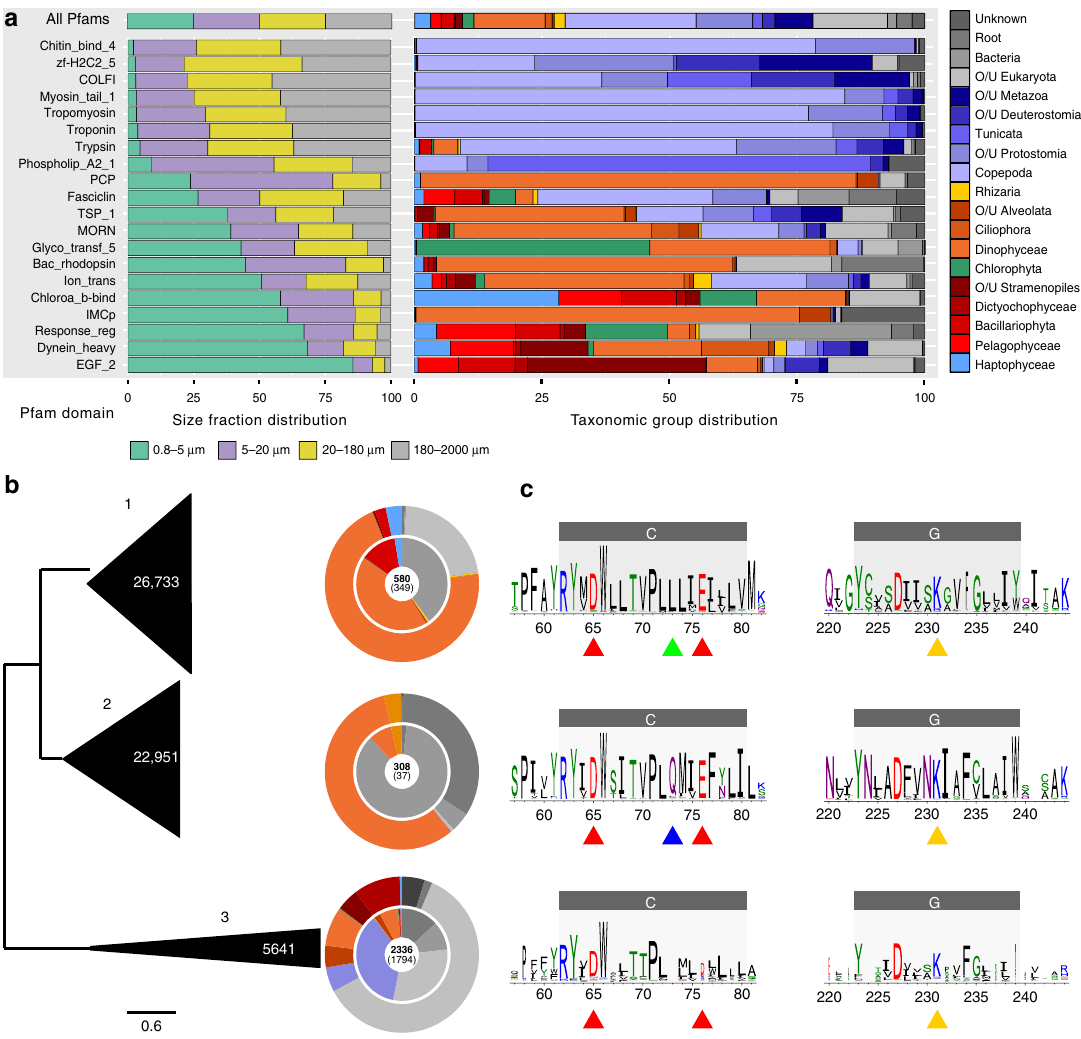
Fig. 3 Characterization of highly expressed gene families. a Major Pfam domains present in different size fractions and in different taxonomic groups. Among the highly expressed Pfam domains (Supplementary Fig. 4), those with speci fi c patterns are shown. The relative expression of Pfam domains in the four fi lter sizes (left panel) and the contribution of each taxonomic group to the total expression of the Pfam domain (right panel) are shown as an average of all Tara Oceans SRF and DCM samples. O/U, other or unassigned. b Unrooted phylogenetic tree of type-I rhodopsin subfamilies (PF01036) obtained using sampling of 300 sequences of the three largest MCL clusters (see details in Supplementary Fig. 5b). The vertical size of the triangles represents the number of unigenes in each cluster (explicitly indicated in white) and their width represents the maximum branch length of 95% of sequences in the cluster. Taxonomic assignments of reference sequences (inner ring) and unigenes (outer ring) are indicated for each cluster with the color code of a . The number of reference sequences in each cluster is indicated in the center in bold, with the number of eukaryotic sequences in parentheses. c Logo consensus sequences, based on the global alignment of each cluster. Two regions of interest (helices C and G and their neighborhoods) containing functional and conserved residues are represented 25 . Speci fi c functional residues are indicated with arrows. Red: proton donor (D65) and acceptor (E76); green: residue speci fi c to green light-sensitive proteorhodopsins; blue: amino acid speci fi c to blue light-sensitive proteorhodopsins; yellow: lysine residue linked to retinal. Predicted transmembrane helices are represented as gray